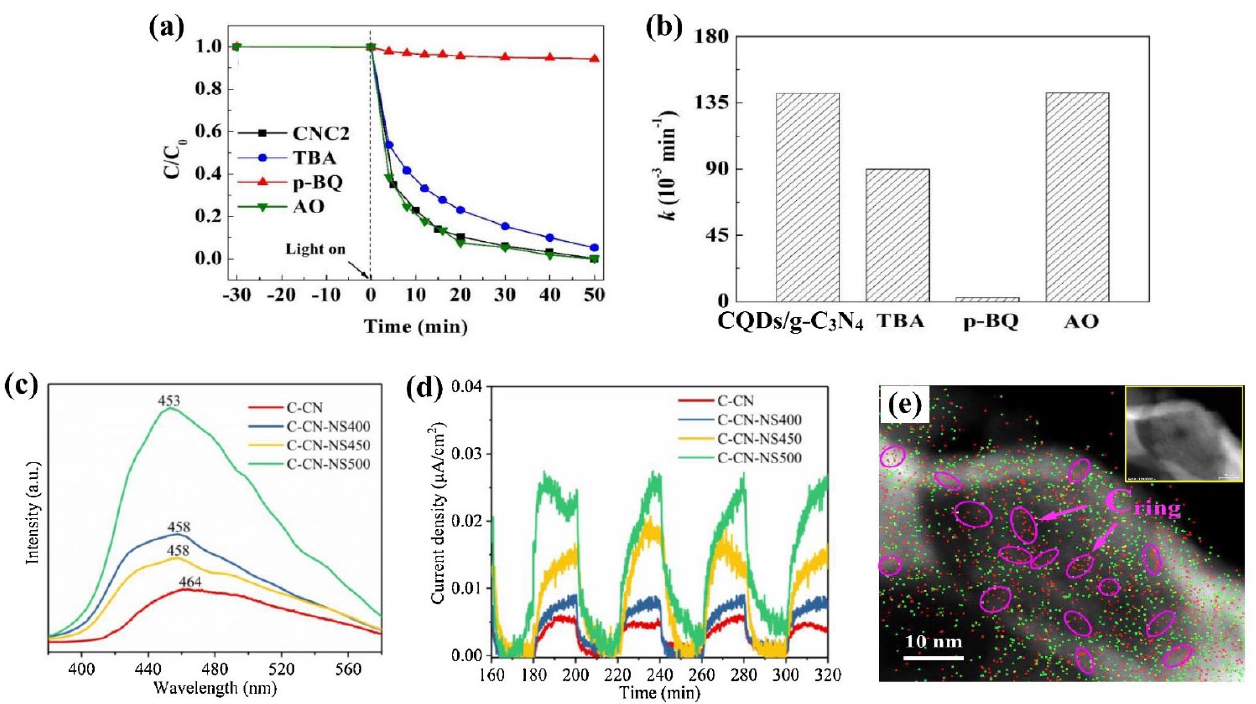
Figure 6. ( a , b ) Effects of variant scavengers (1 mM ammonium oxalate (AO), 50 µ M tert-butyl alcohol, 50 µ M, and p-benzoquinone (p-BQ) on the degradation efficiency for diclofenac, ( c ) fluorescence emission spectrum of CQDs/g-C 3 N 4 and different samples ( d ) transient photocurrent densities of CQDs/g-C 3 N 4 and different samples, and ( e ) energy dispersive X-ray spectroscopy of CQDs/g-C 3 N 4 (inset: transmission electron microscopy image of the corresponding region). Reproduced with permission from Refs. [34,68,69] with license number 5043061194671, 5043061353580,